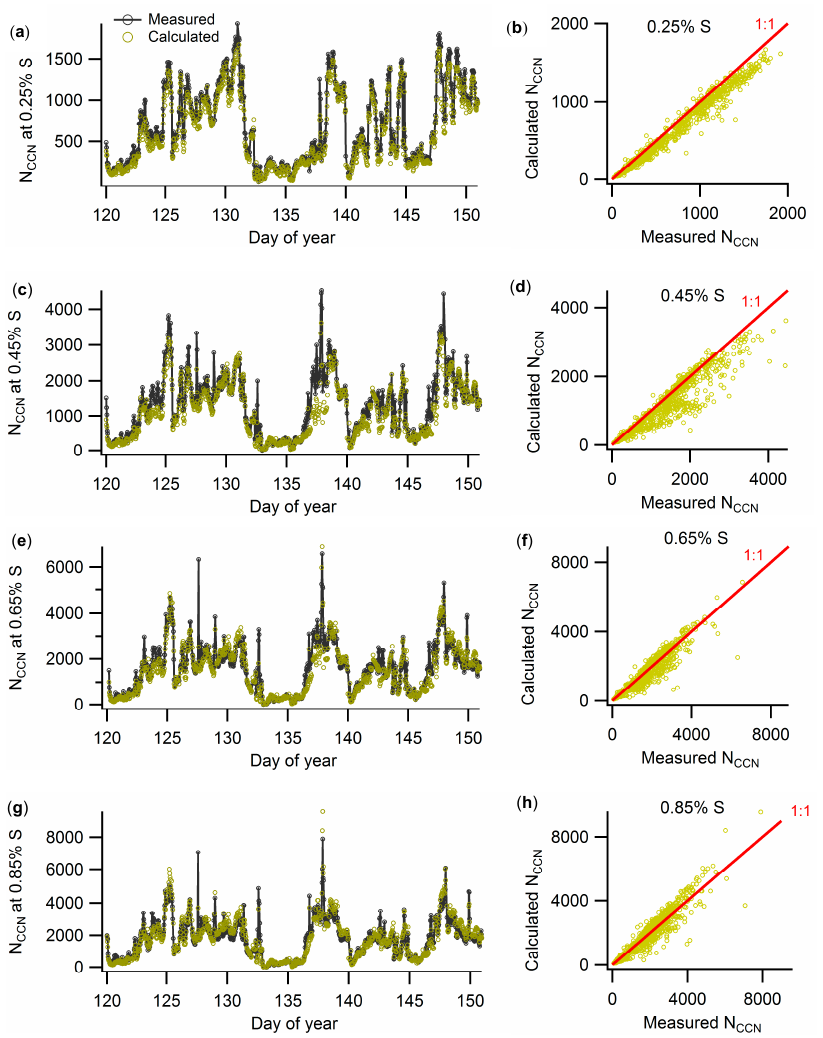
Figure 7. Comparison between measured and estimated N CCN (cm − 3 ) for May 2011 at 0.25% ( a , b ); 0.45% ( c , d ); 0.65% ( e , f ); and 0.85% S ( g , h ). The dotted lines in the scatter plots represent +/ − 20% relative to the 1:1 line.